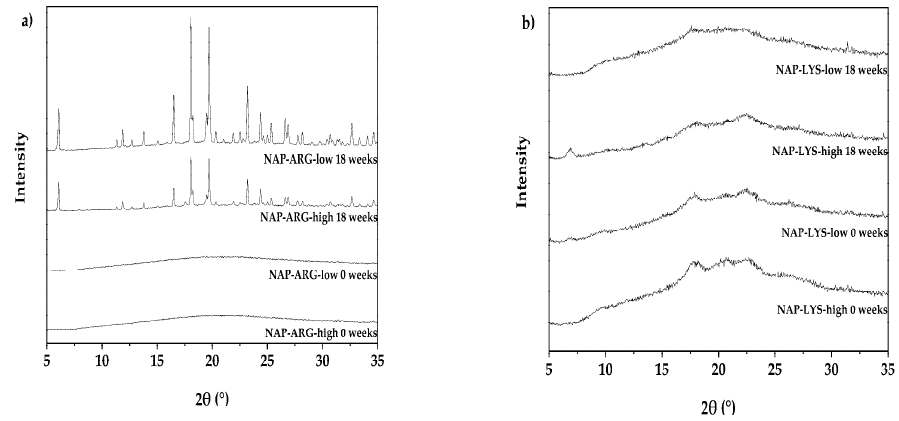
Figure 3. Physical stability by XRPD for different naproxen-amino acid (NAP-AA) salts comparing fresh samples (0 weeks) and stored samples (18 weeks), naproxen-arginine (NAP-ARG) salts ( a ) and naproxen-lysine (NAP-LYS) salts ( b ).